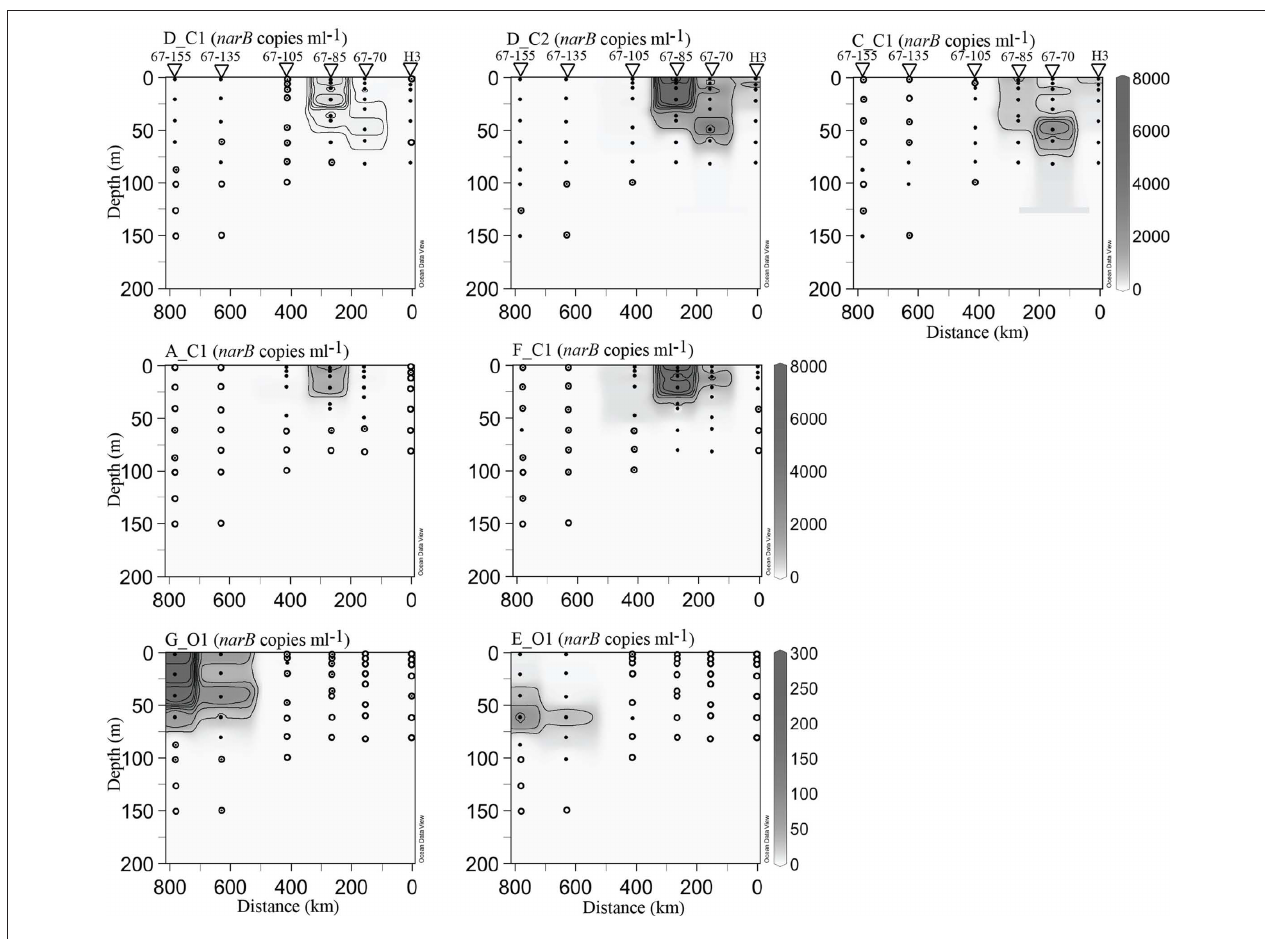
FiguRe 7 | narB subgroup abundances along profiles from station H3 to station 67–155 (see Figure 1). The abundance scale ( z -axis) is in gene copies ml − 1 . Black circles mark samples containing quantifiable amounts of narB subgroups, concentric circles mark locations where subgroups were detected but not quantifiable and hollow circles mark locations where narB